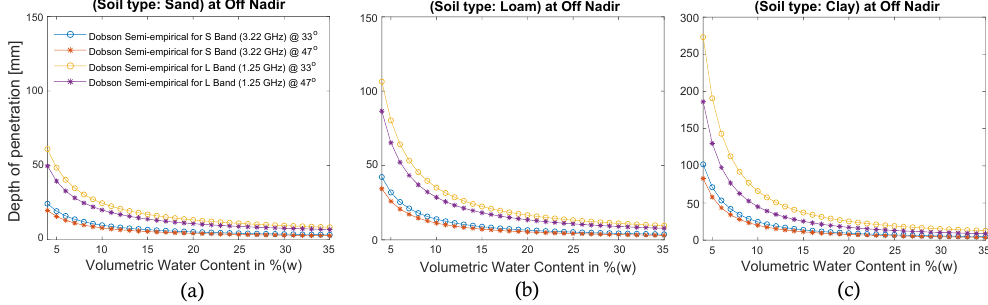
Figure 4. Penetration depth (mm) of SAR pulses (L- and S-band) as a function of volumetric water content (in %) at different incidence angle in ( a ) sandy, ( b ) loamy, and ( c ) clayey